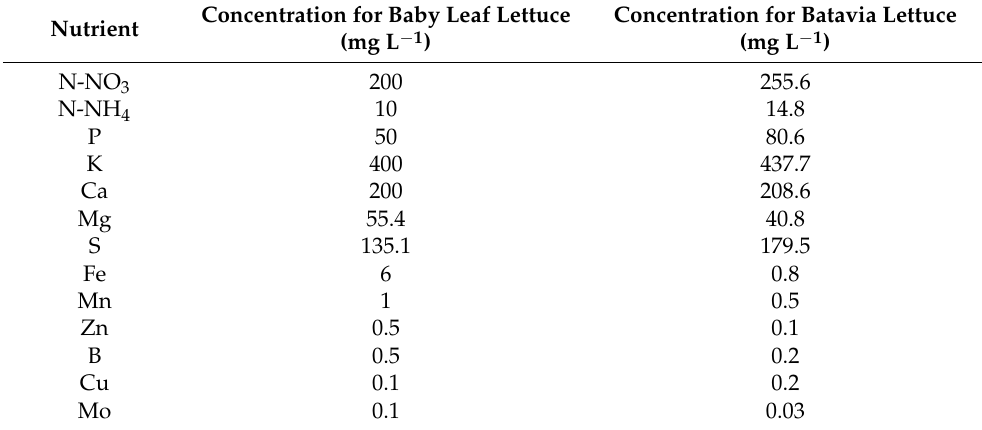
Table 2. Nutrient concentrations of the fertigation solution used for the conventional growing system